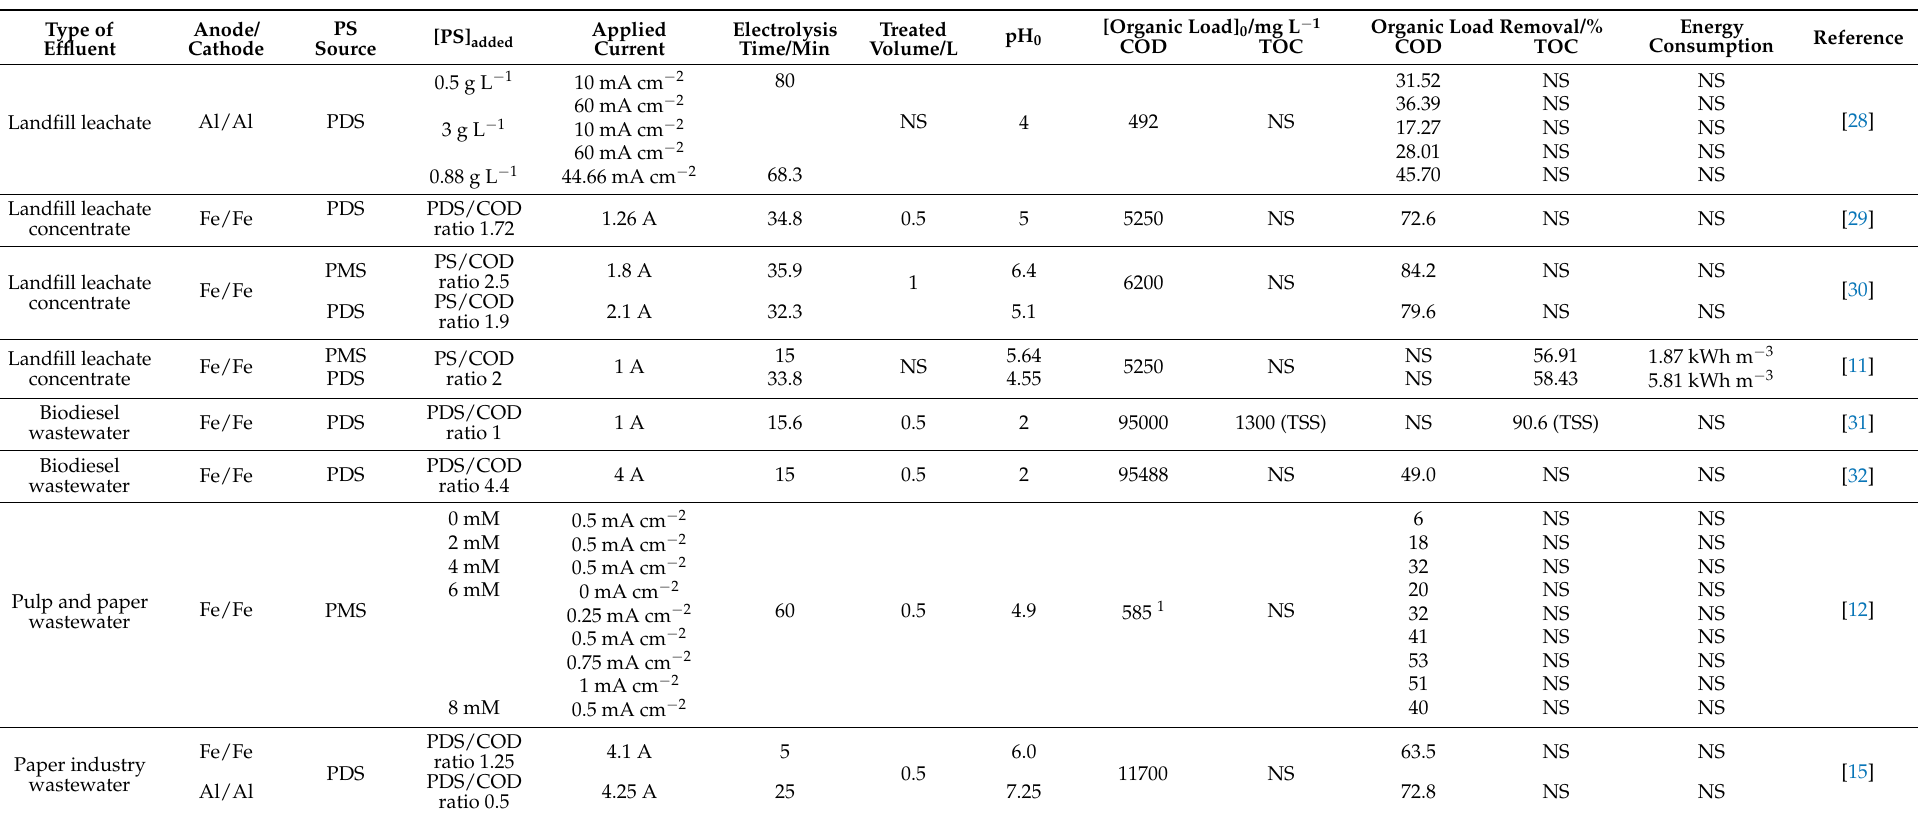
Table 2. Summary of research results previously reported for persulfate electro-activation through sacrificial anodes in the treatment of complex